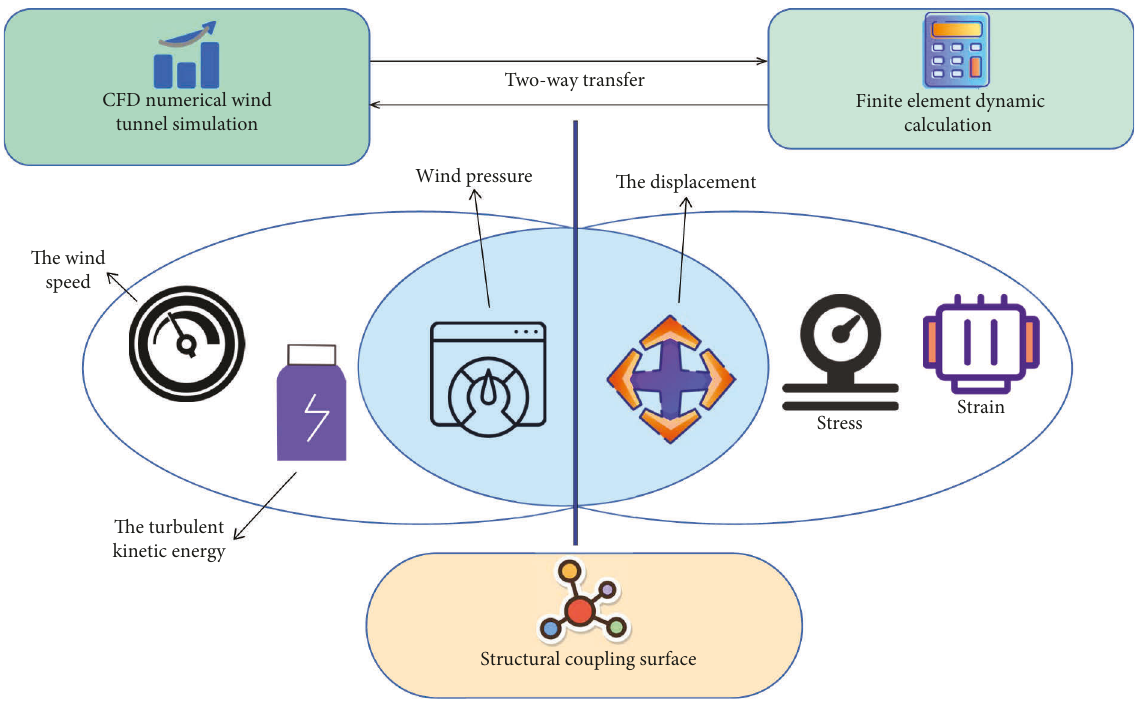
Figure 1: The innovation and entrepreneurship coupling of the simultaneous equation